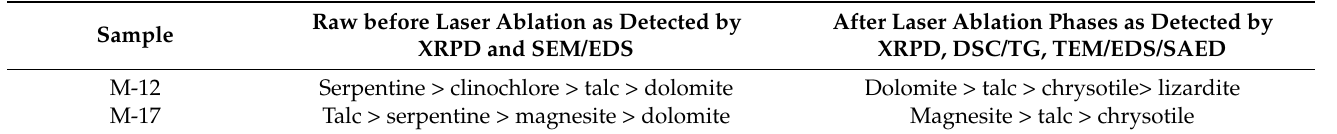
Figure 7. XRPD of sample M-12, whole rock before ablation, where peaks of a serpentine phase (antigorite) and carbonate (dolomite) are preeminent, also containing some talc and chlorite. Table 2. Mineralogy of samples before (raw sample) and after laser